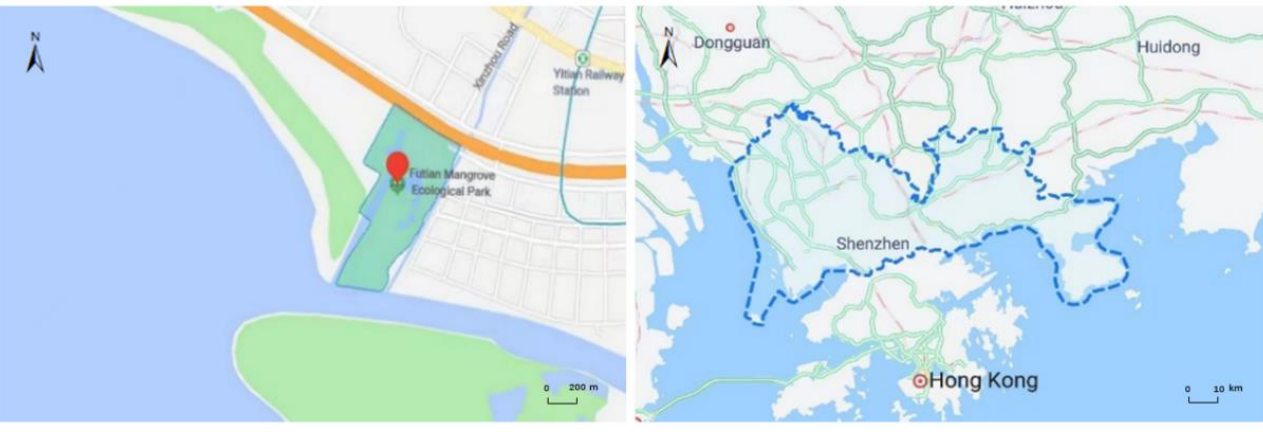
Figure 2. Location of the Mangrove Park.